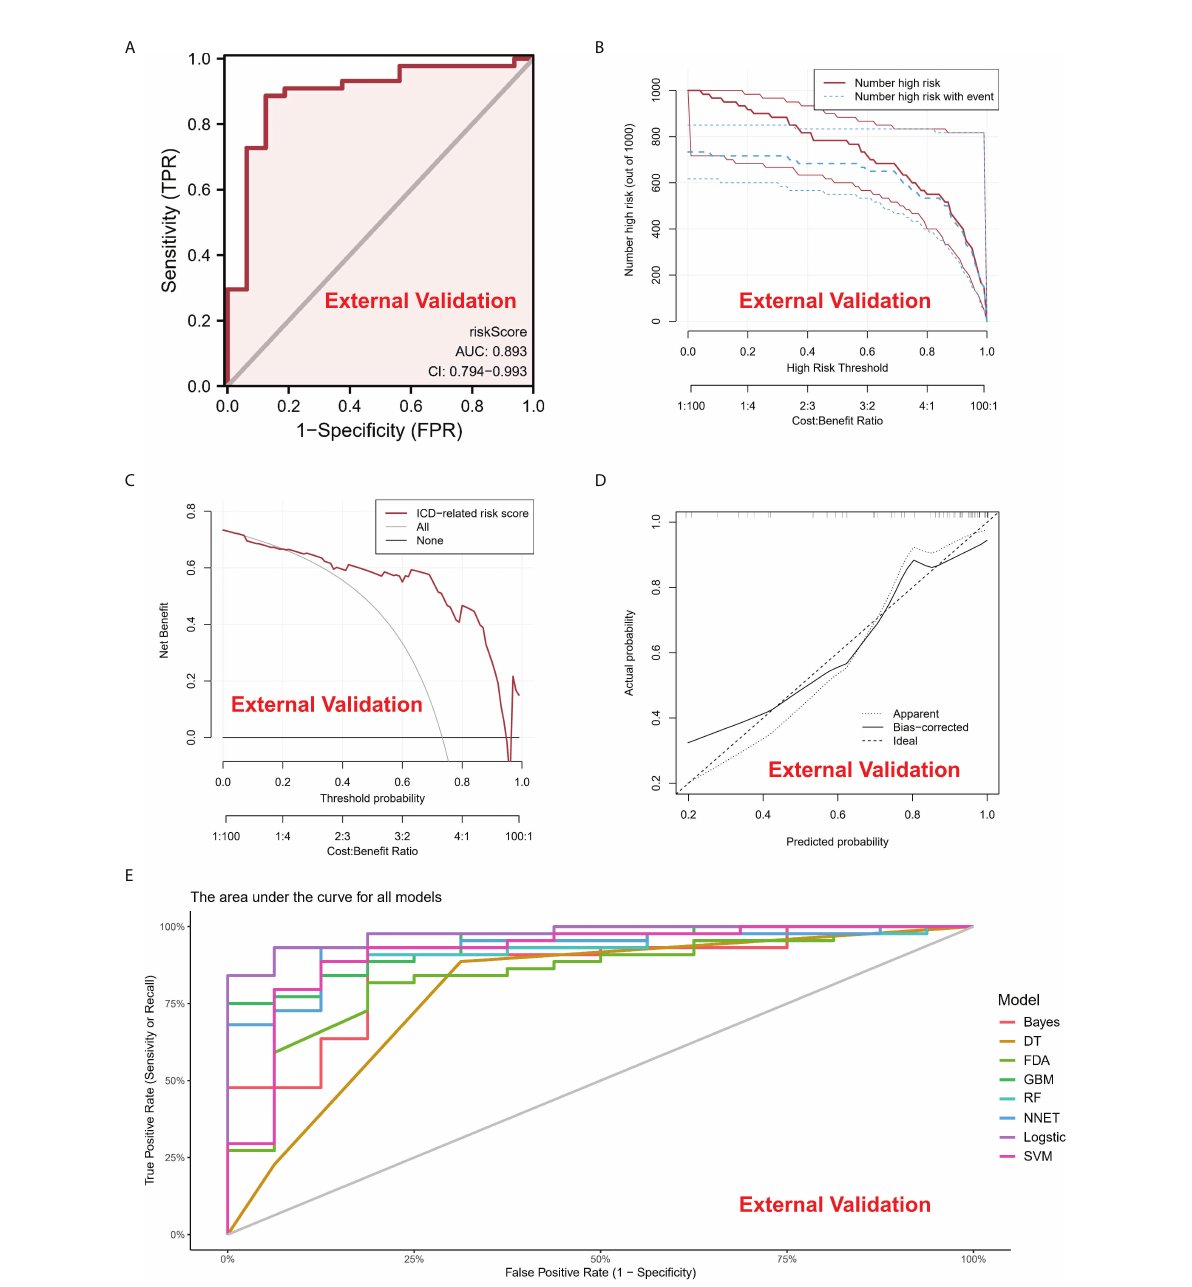
FIGURE 4 (A) In the External Validation cohort, the ROC curve and AUC value were used to study and assess the capacity of ICD-regulators to distinguish between normal and IA samples. (B – D) . The clinical impact, decision, and calibration curves for the model in the external validation dataset. (E) AUC values of all models in the External Validation